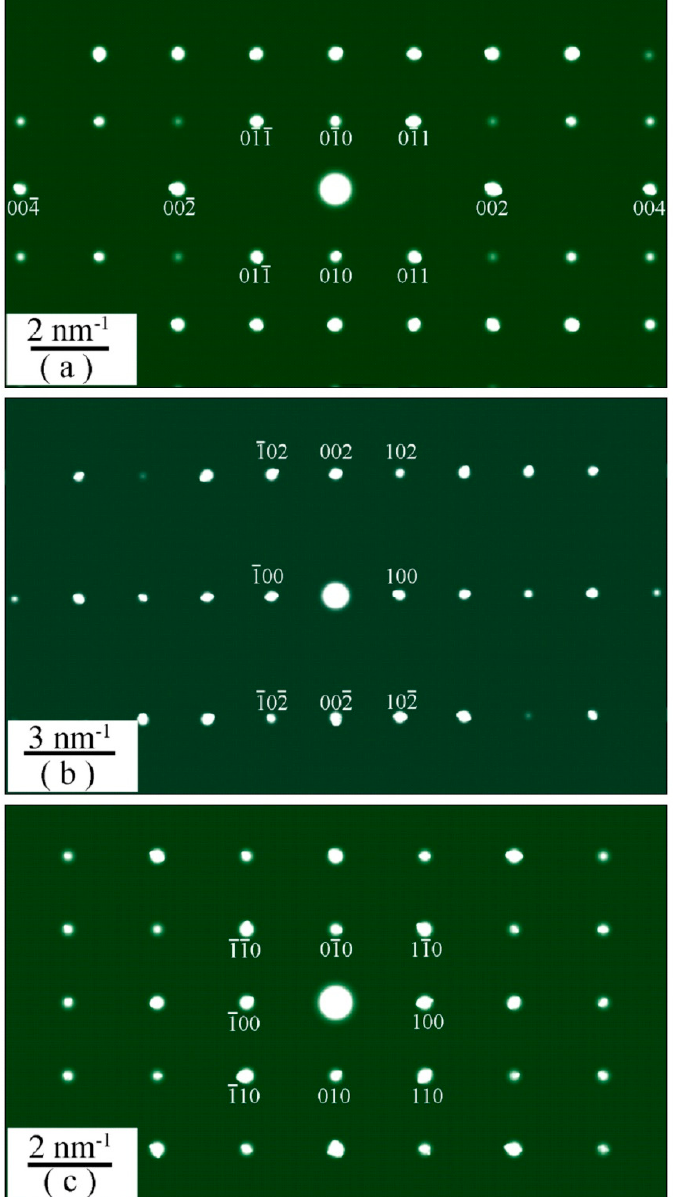
Figure 19. Selected area electron diffraction patterns of ZnWO 4 nanoplates with different facets: ( a ) {100} facet; ( b ) {010} facet; and ( c ) {001} facet. The operation voltage of the TEM machine was 200